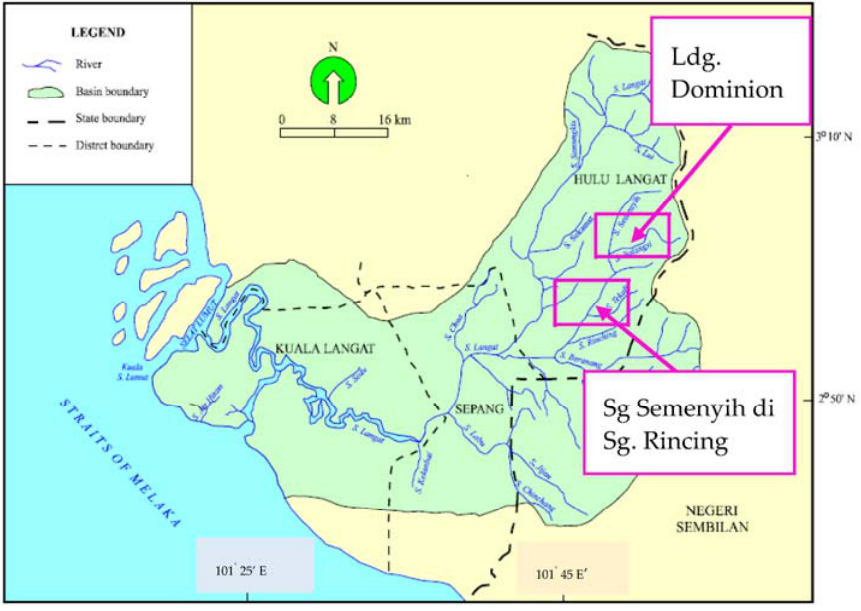
Figure 3. Langat River Basin.